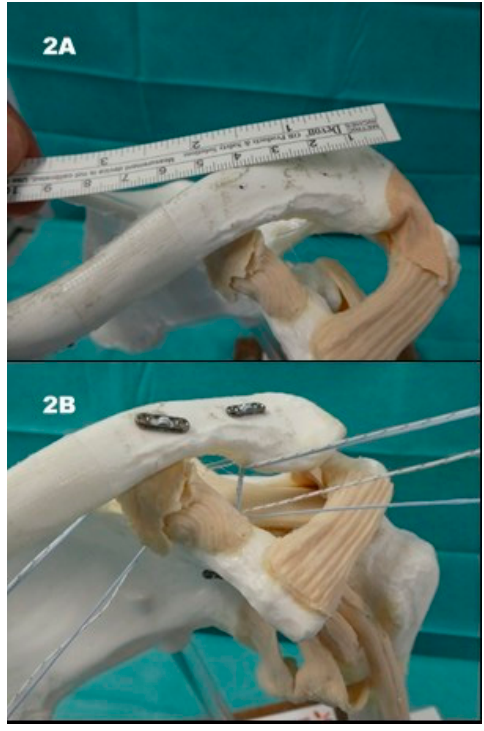
Figure 2. MINAR model: ( 2A ) at least 2 cm distance between drill holes at the lateral clavicle; ( 2B ) V-shaped array of the triple-button system. Knotting between coracoid and clavicle.